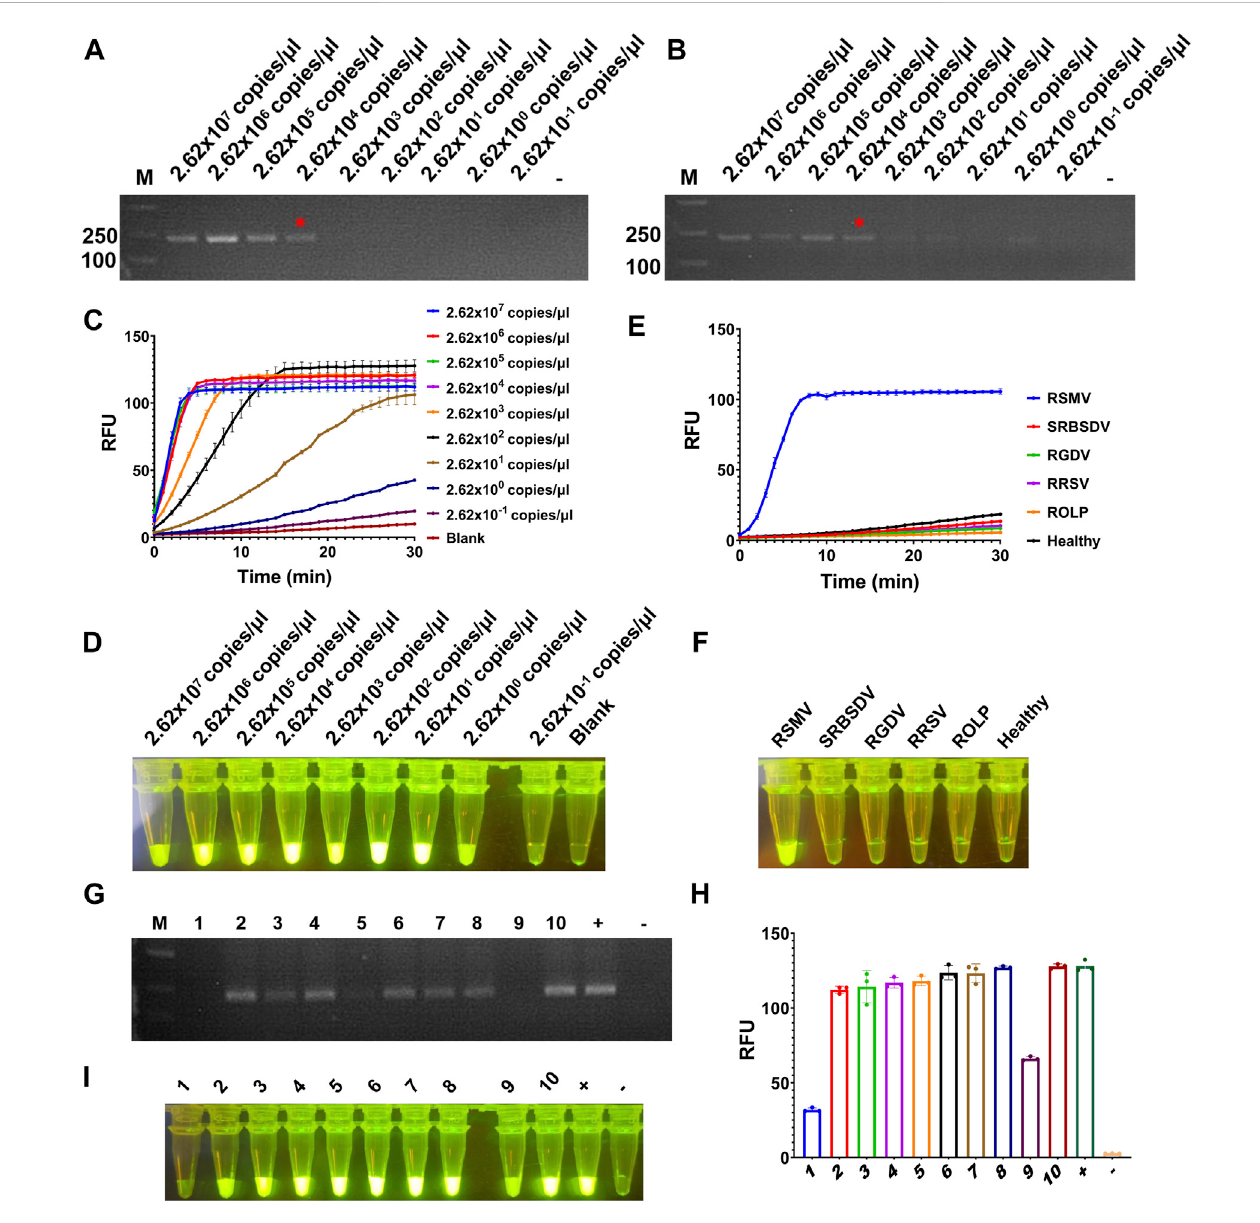
Sensitivity and speci fi city assay for RT-RAA-CRISPR/Cas12a detection for RSMV. (A) The crude extracts of RSMV infected rice leaves were diluted gradiently and tested by RT-RAA. (B) The crude extracts were diluted gradiently and tested by RT-PCR. (C) The crude extracts were diluted gradiently and testedbyRT-RAA-CRISPR/Cas12adetection method,andthereal-time fl uorescencesignalwascontinuouslymonitoredfor30 min.Waterwasusedasblank control. (D) The gradiently diluted crude extracts were tested by RT-RAA-CRISPR/Cas12a method and followed by visual observation. (E) The crude extracts of rice samples infected with different pathogens were tested by RT-RAA-CRISPR/Cas12a detection method, and the real-time fl uorescence signal was continuously monitored for 30 min. Healthy plant sample was used as control. (F) The crude extracts of rice samples infected with different pathogens were tested by RT-RAA-CRISPR/Cas12a method and followed by visual observation. (G) The crude extracts of single leafhopper samples were tested by RT- PCR. (H) The crude extracts of single leafhopper samples were tested by RT-RAA-CRISPR/Cas12a detection method, and the fl uorescence signal was quantitative monitored by microplate reader. (I) The crude extracts of single leafhopper samples were tested by RT-RAA-CRISPR/Cas12a detection method and followed by visual observation. RSMV: rice stripe mosaic virus, SRBSDV: southern rice black-streaked dwarf virus, RGDV: rice gall dwarf virus, RRSV: rice ragged stunt virus, ROLP: rice orange leaf phytoplasma. n = 3 technical replicates, and data points are shown as mean ±